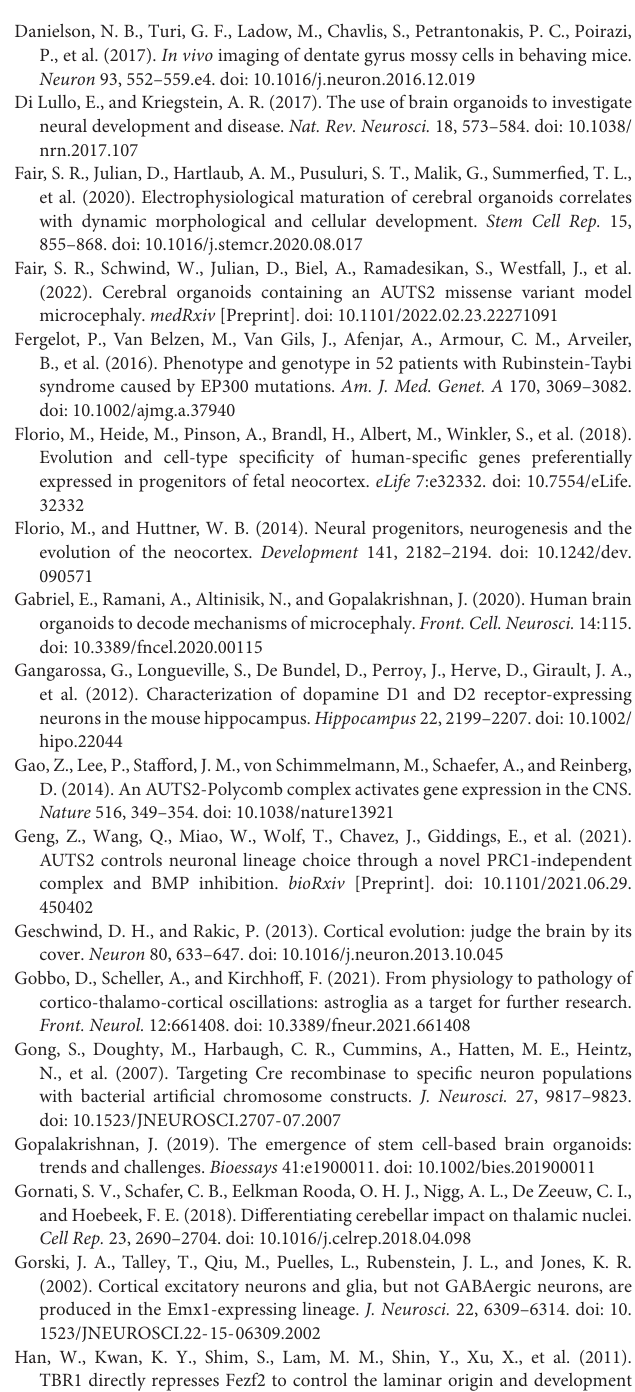
Supplementary Figure 5 | Predictive modeling of the AUTS2 domain of FBRSL1 protein. The AUTS2 domain of FBRSL1 protein (aa 587–784) was modeled using RoseTTAfold. Left panels show predicted structures, and right panels show error estimates for each aa position, for models 1–5. Overall confidence was low (0.42 on scale 0–1), most likely because no structures of similar sequences were available. All of the models show stretches of disordered secondary structure with intervening alpha helices. Models not shown to the same scale. of IDRs and